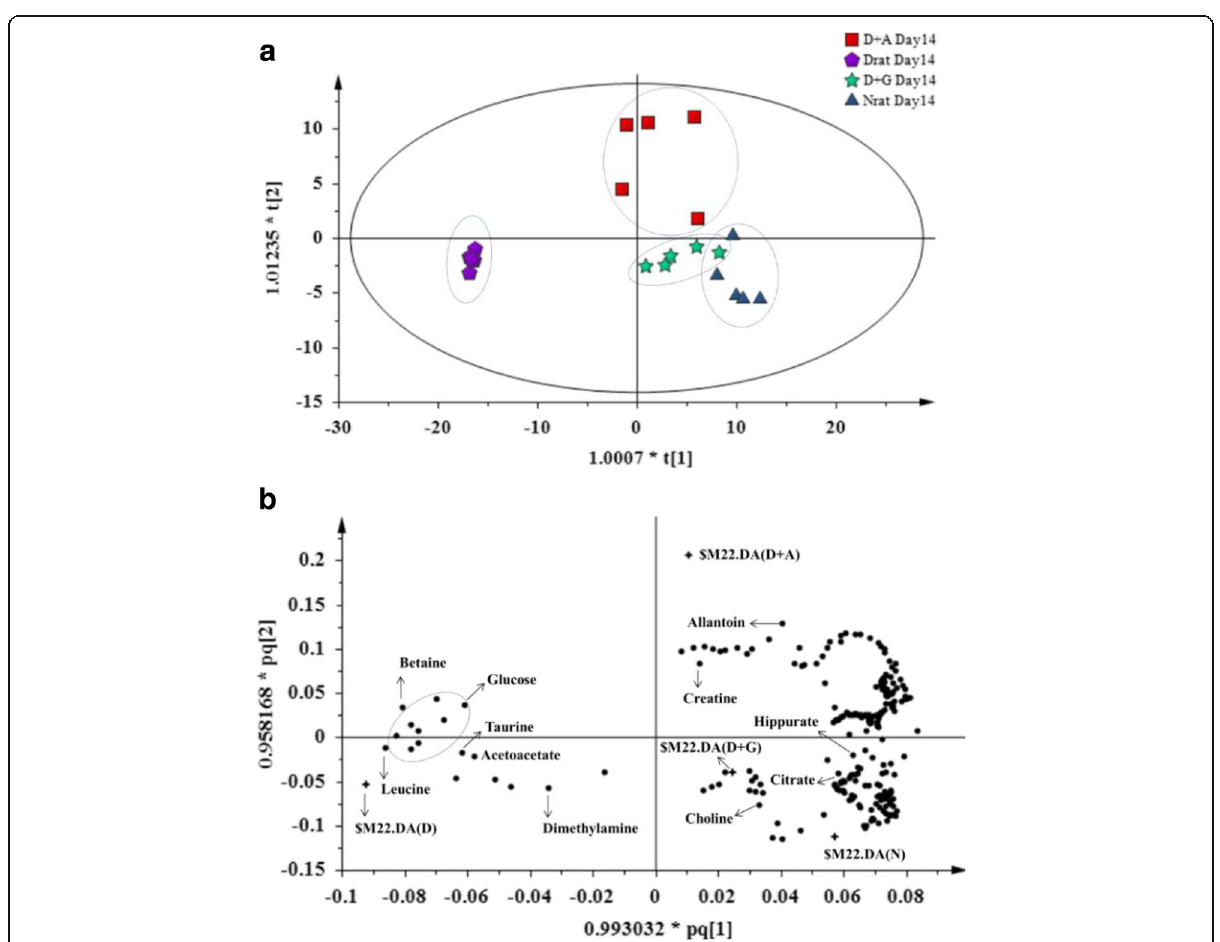
Fig. 4 OPLS-DA score plot a (14 day) and b loading scatter plot based on 1 H NMR spectra of normal (N), diabetic (D), D-A and D-G rat